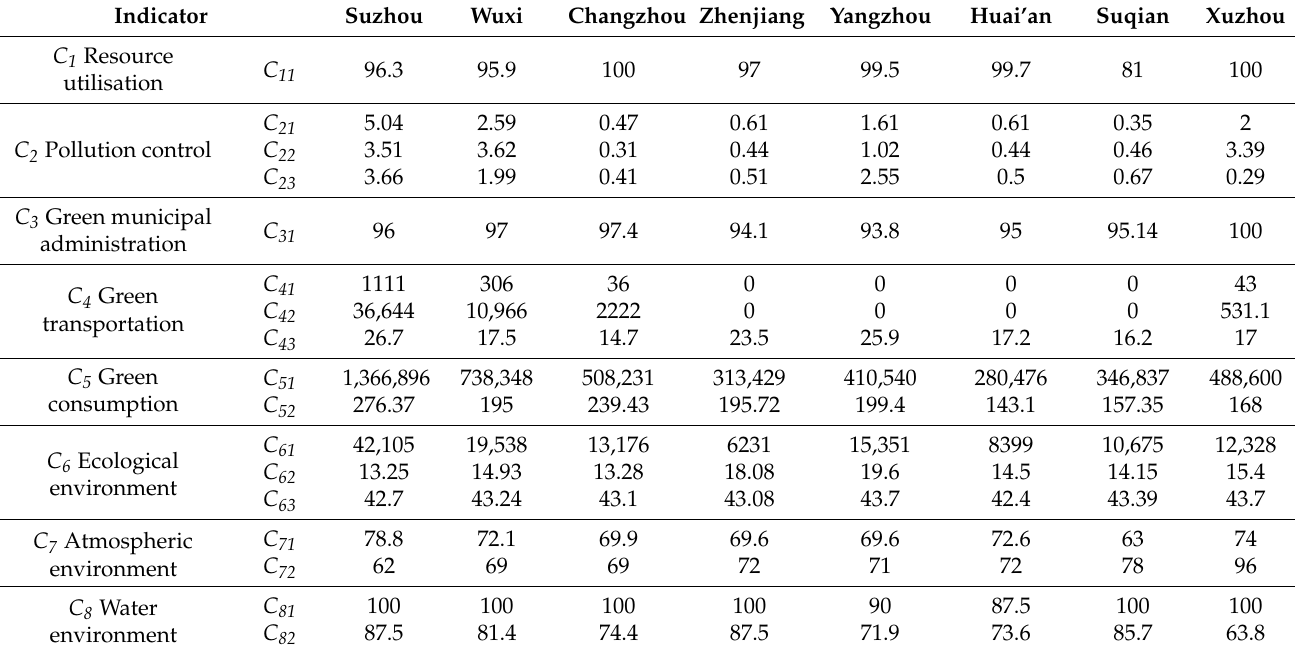
Table A1. Quantitative data on evaluation indicators for